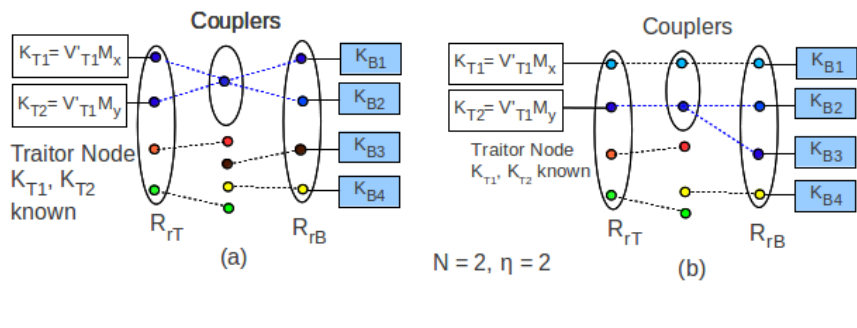
Figure 5. The traitor node cannot be used to attack the